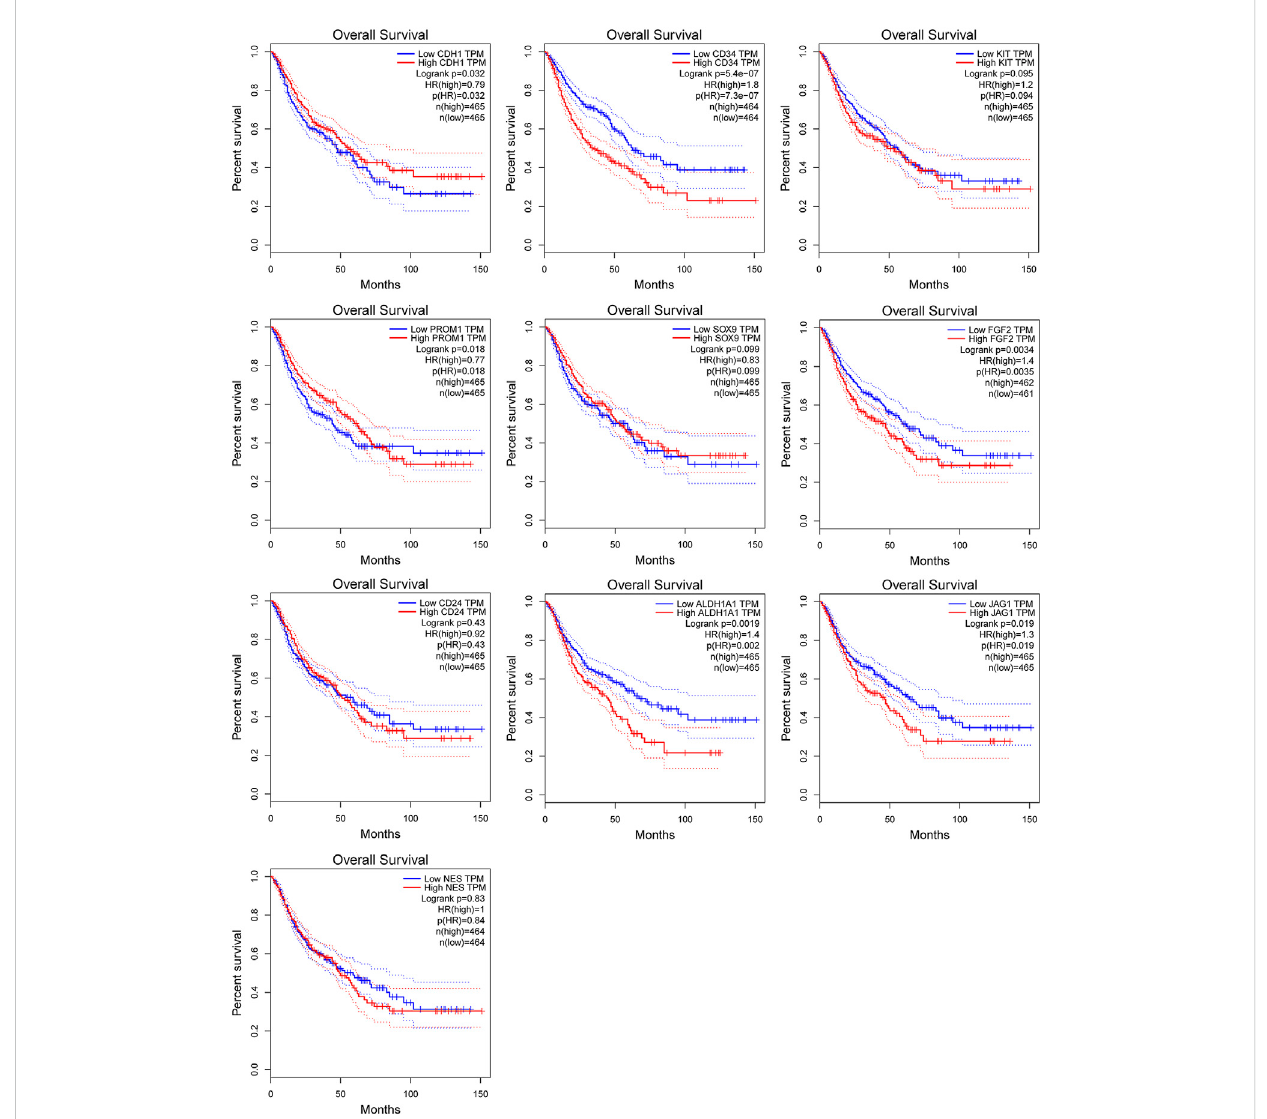
FIGURE 9 Kaplan-Meier curves of hub genes expression and overall survival in gastrointestinal tumors. Data are presented as the hazard ratio with a 95% con fi dence interval. Log-rank p < 0.05 was regarded as statistically signi fi cant.